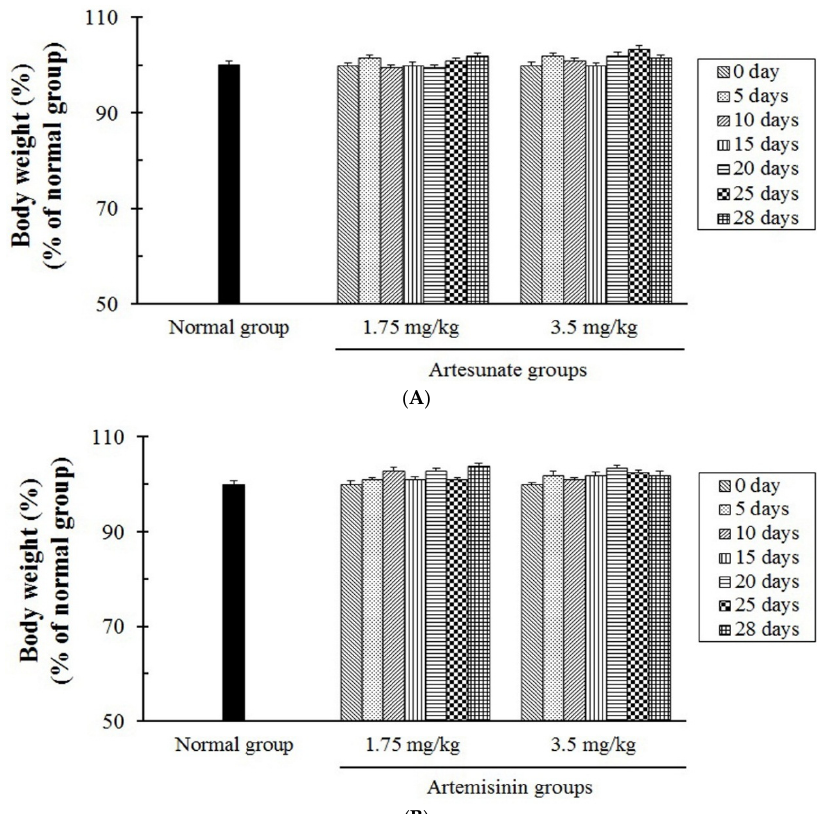
Figure 6. Changes of the body weight in rats following administration of artemisinin and artesunate. ( A ) The groups administered artesunate; and ( B ) the groups administered artemisinin. The rats were divided into a normal group ( n = 4) and experimental groups ( n = 8/artesunate two groups, n = 8/artemisinin two groups, n = 4/each group). The rats were orally administered with two different doses (1.75 and 3.5 mg/kg) of artemisinin and artesunate, once a day for four weeks, respectively, and additionally observed for seven days. The results were expressed as a percentage of the normal group and presented as the mean ± S.D.